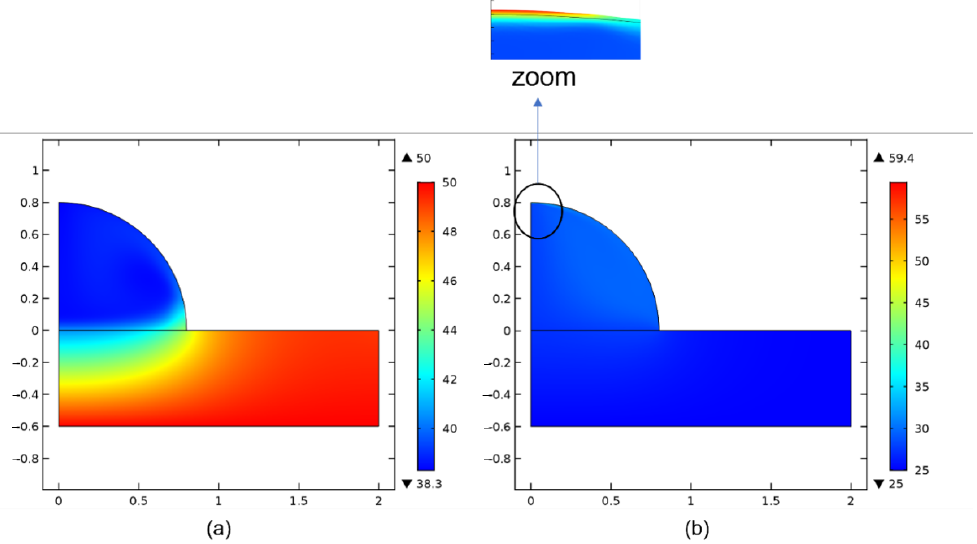
Figure 7. Temperature field for two configurations. (t = 1 s, θ = 90 ◦ , V 0 = 1 mm 3 ) ( a ): BH (T h = 50 ◦ C) ( b ): TH ( Φ = 40 mW).